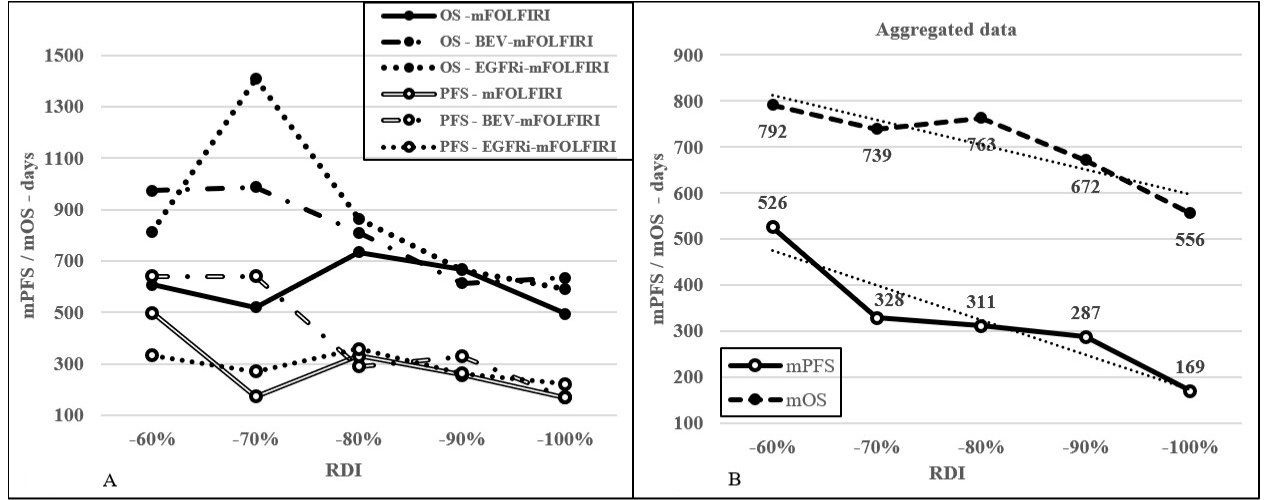
Figure 5. Effect of DI reduction (decreasing by 10% per group) on mPFS and mOS in each treatment type ( A ) and the aggregated data ( B ).